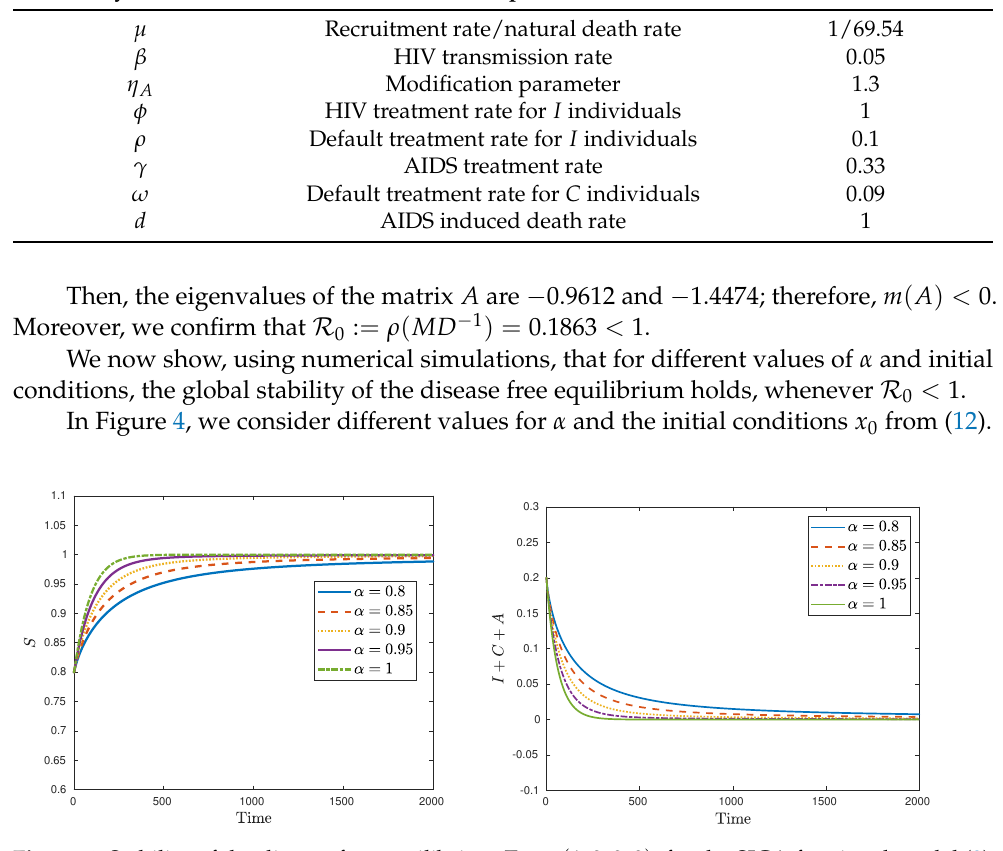
Figure 4. Stability of the disease free equilibrium Σ 0 = ( 1,0,0,0 ) , for the SICA fractional model (9), considering different values of α ∈ { 0.8,0.85,0.9,0.95,1.0 } . On the left: S . On the right: I + C + A